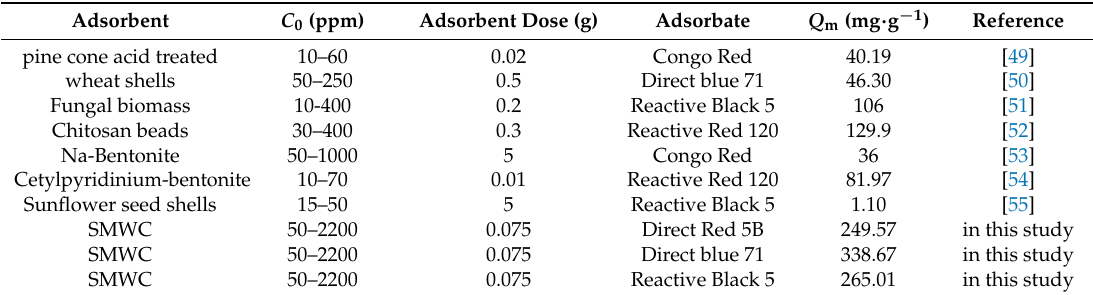
Table 1. Comparison of the maximum adsorption capacities of some anionic dyes on various adsorbents.